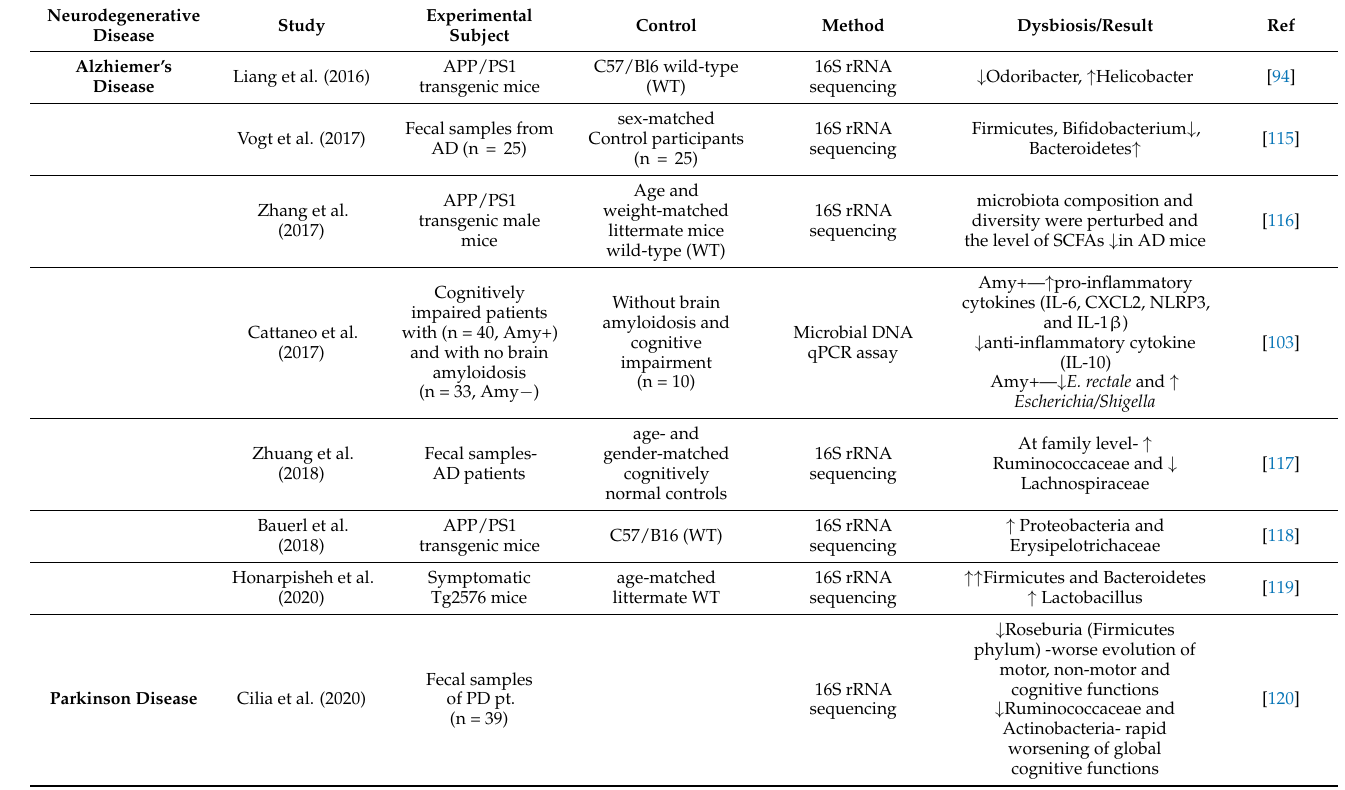
Table 1. Various studies show alteration in gut microbiota in various neurodegenerative disorders. Neurodegenerative